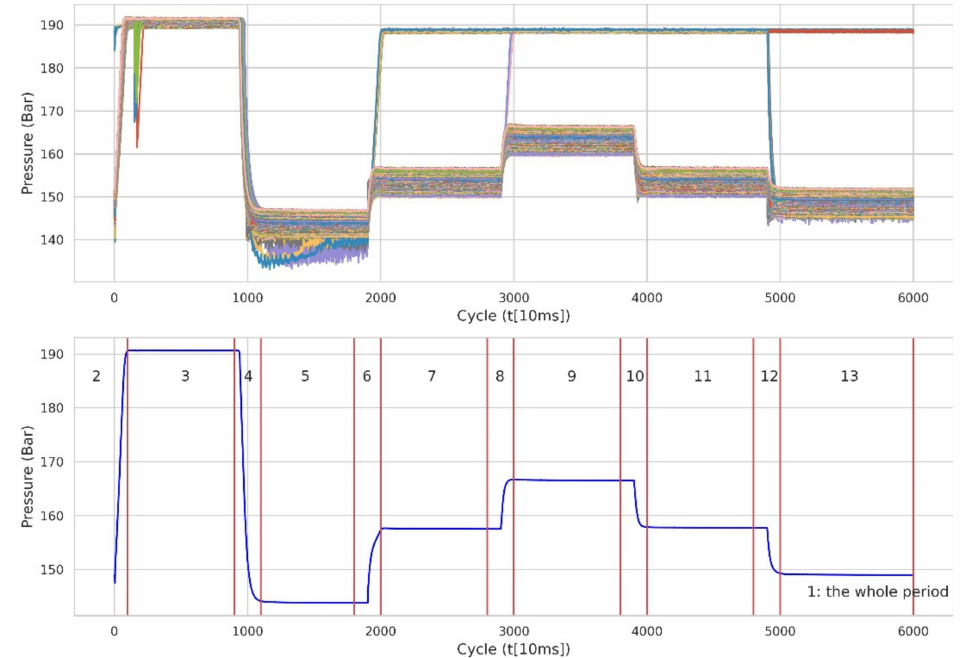
Figure 3. Pre-defined Clusters 1 to 13 for feature